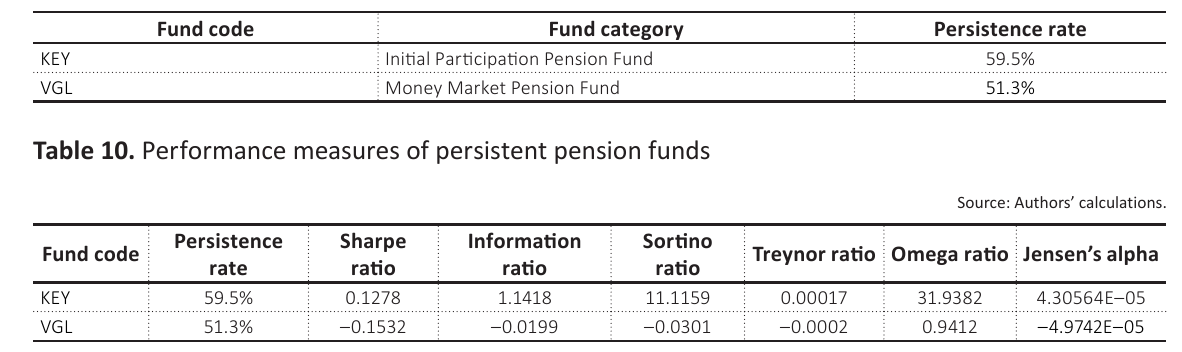
Table 9. Pension funds persistent in performance